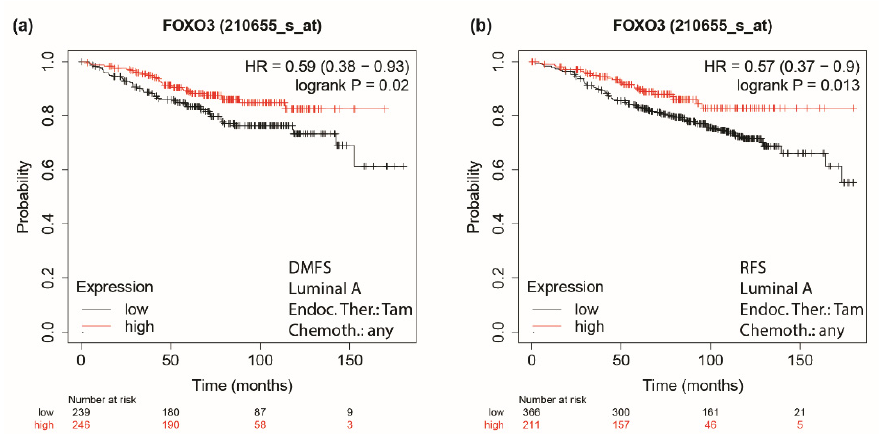
Figure A4. FoxOa is a positive prognostic factor in luminal A BC patients. Distant